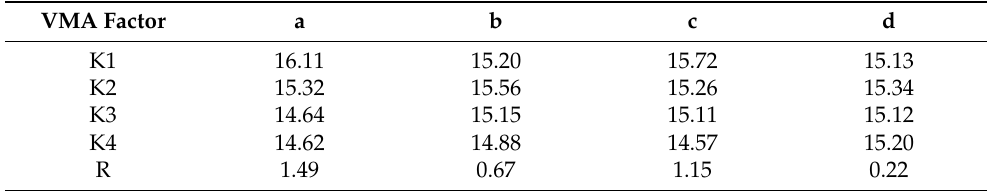
Table 16. VMA range